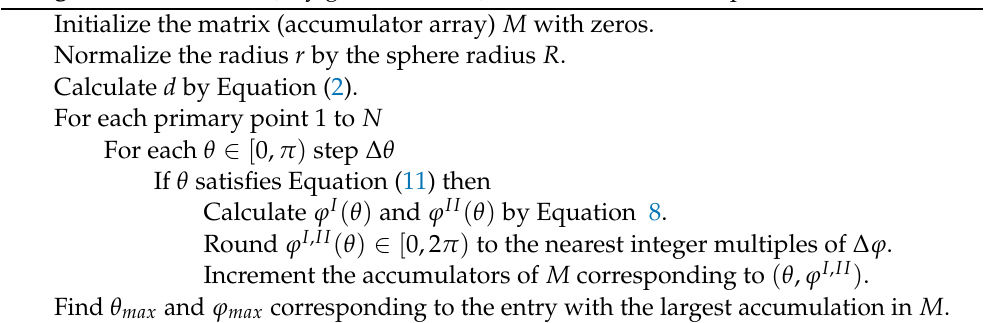
Algorithm 2: General (any given radius r ) circle detection on a sphere Initialize the matrix (accumulator array) M with